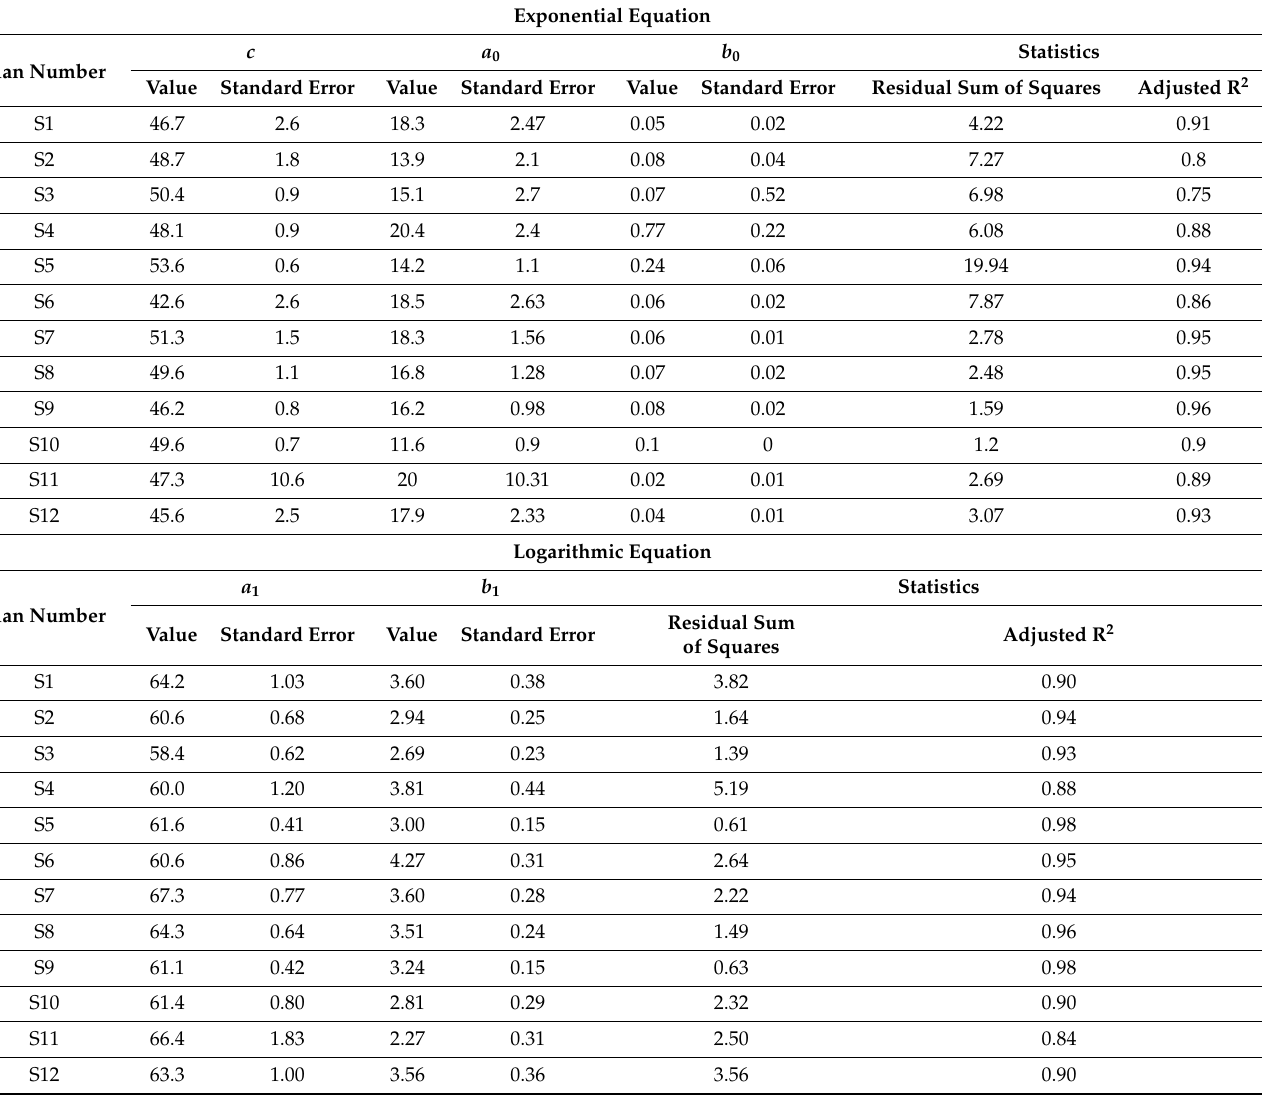
Table 7. BPN attenuation prediction equation